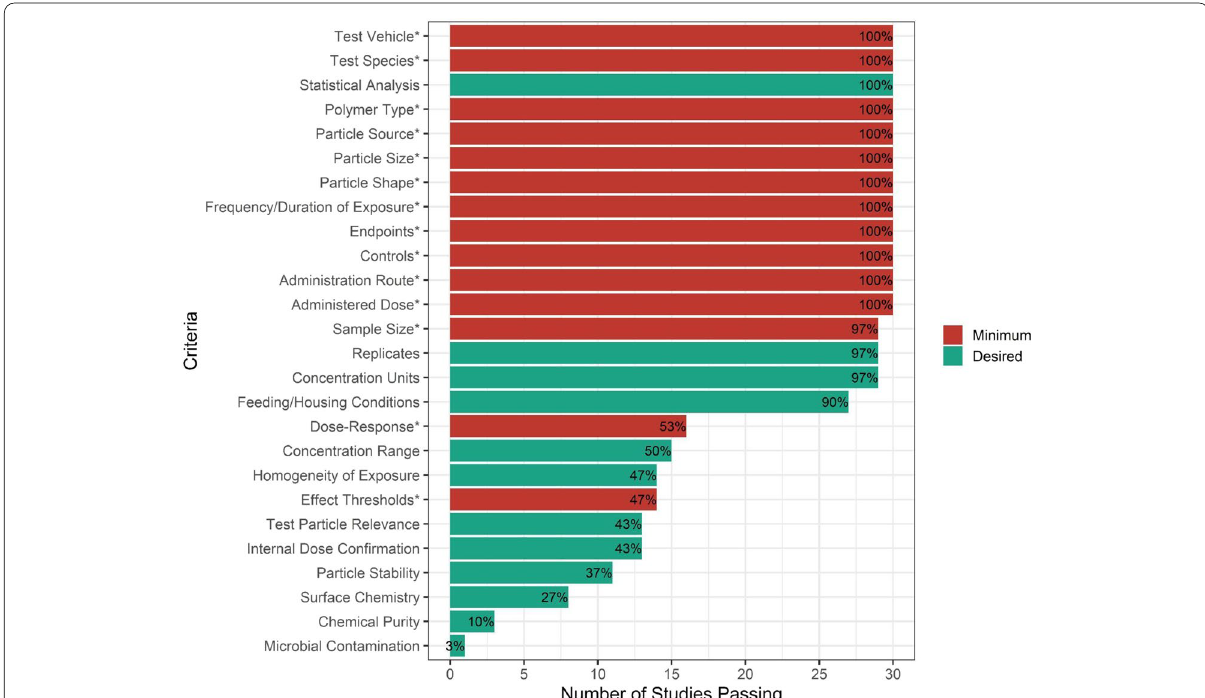
Fig. 2 Summary of the quality screening results for all in vivo mammalian studies against 26 criteria. Prioritized studies should be assigned a score of > 0 against all criteria. In this study, however, due to lack of data, a subset of criteria has been identified as necessary for results to potentially be considered as fit-for-purpose towards helping to inform a dose–response assessment (‘red criteria’); these criteria are displayed in red and indicated by an asterisk (*), with all other screening criteria shown in green. Additional details from the Tier 1 evaluation are reported in the supplemental information (reference figure/tables) and in Gouin et al.,